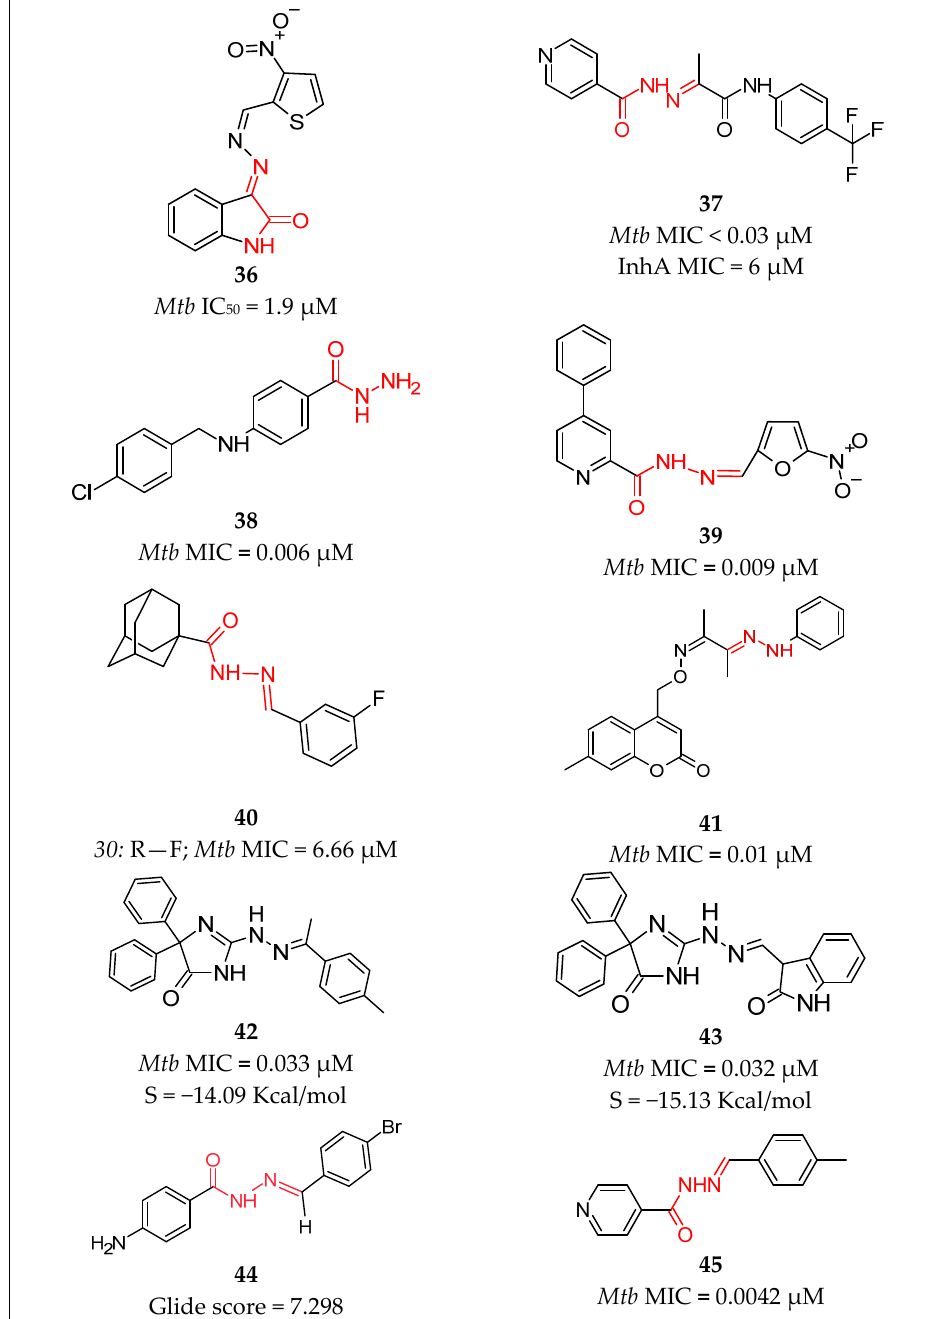
Figure 9. Chemical structures of compound 36 [57], 37 [58], 38 [59], 39 [60], 40 [61], 41 [62], 42 [63], 43 [63], 44 [64] and 45 [65].